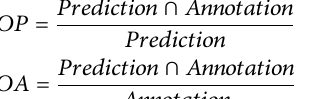
U-Net (Ronneberger et al., 2015)